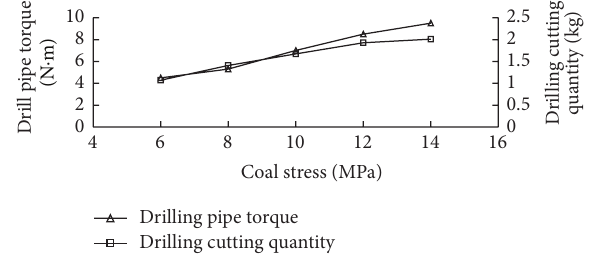
Figure5:Thecomparisonofdrillpipetorque,volumeofdrilledcoal rubble, and coal stress.